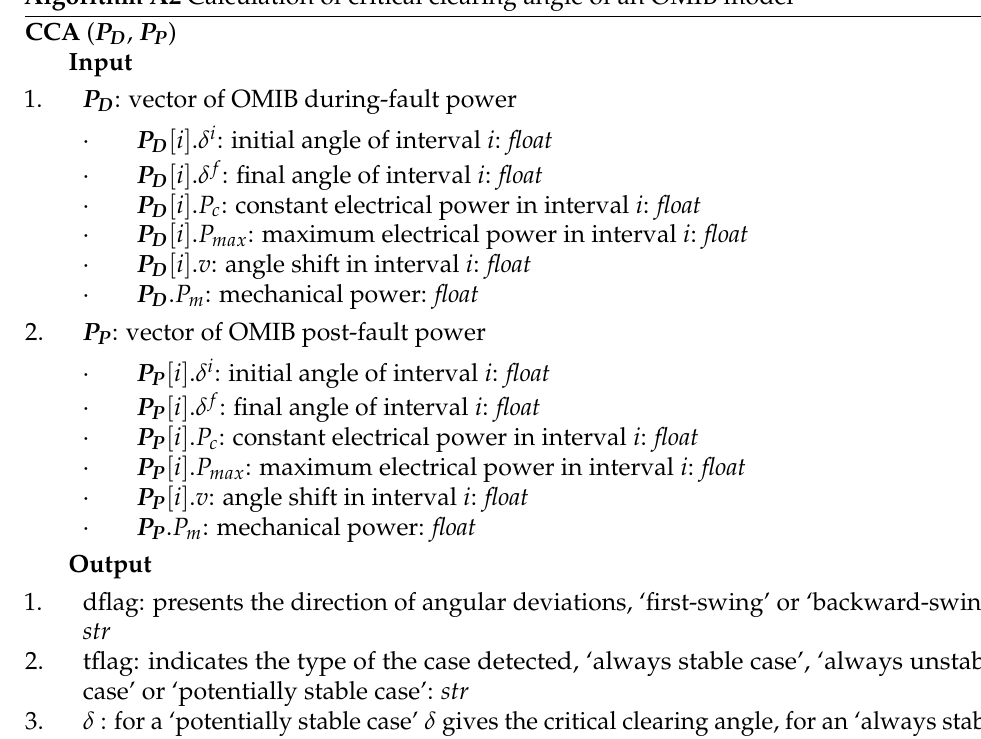
Algorithm A2 Calculation of critical clearing angle of an OMIB